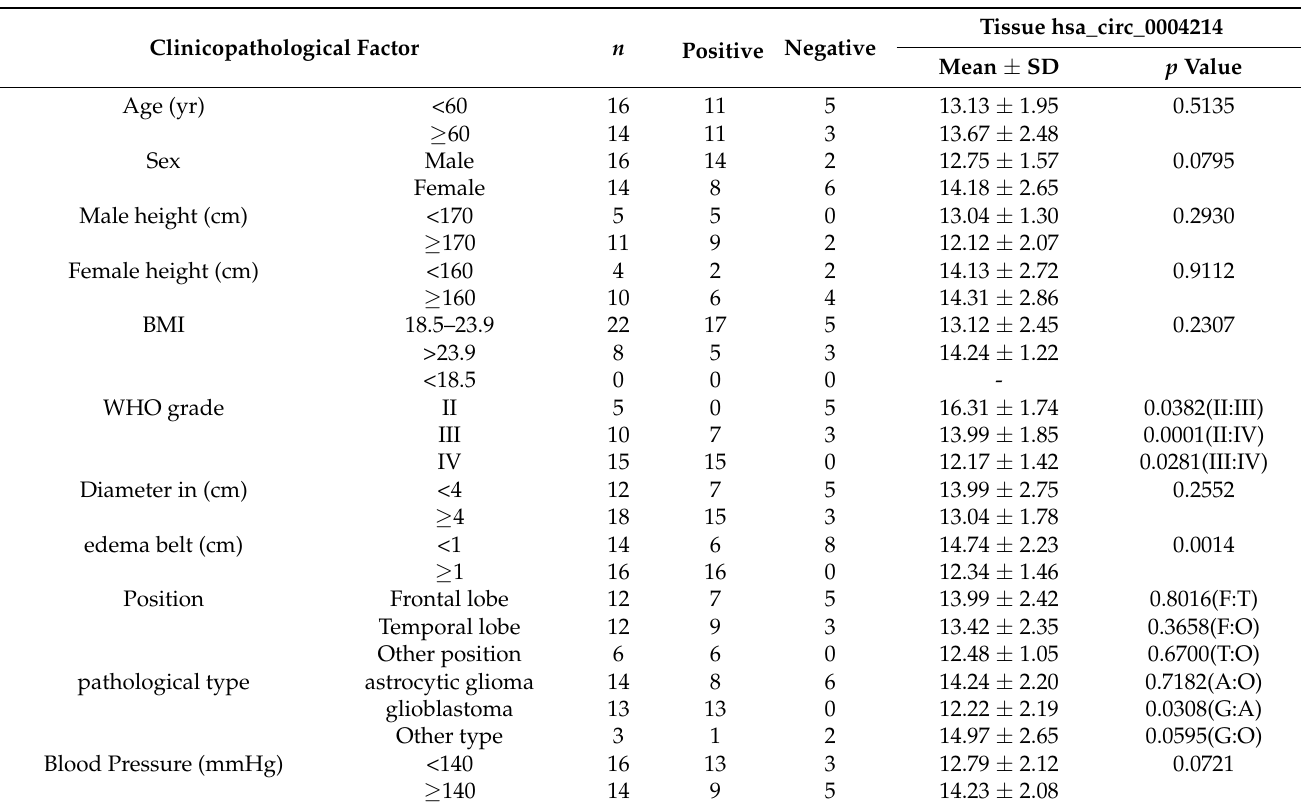
Table 5. Relationship of hsa_circ_0004214 expression levels ( ∆ Ct) in glioma tissues with clinicopatho-